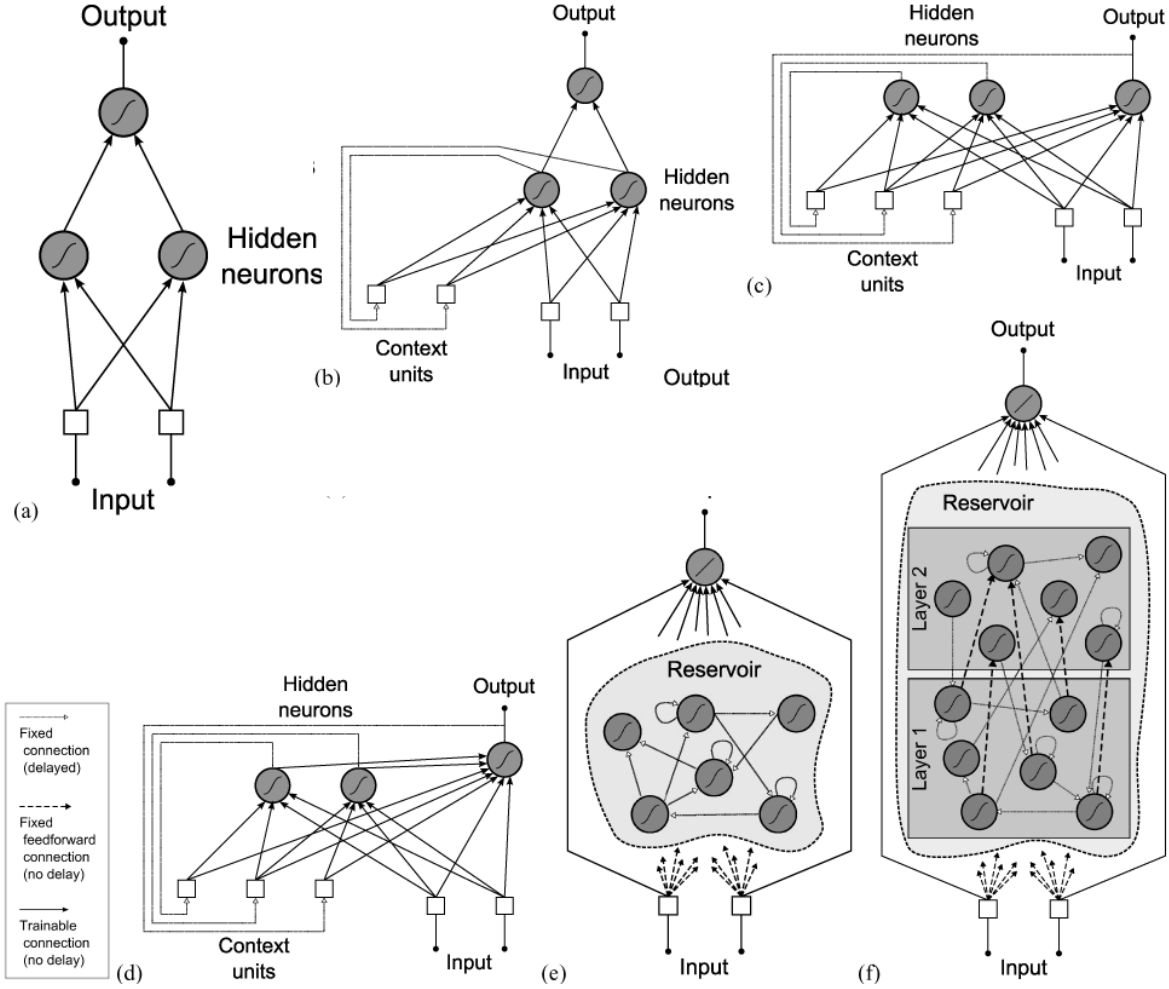
Fig. 1. (a) Feedforward ANN. (b) Elman recurrent ANN. (c) Williams–Zipser fully recurrent ANN. (d) Williams–Zipser fully recurrent and fully feedforward ANN. (e) Echo State Network. (f) Layered Echo State Network. Note: bias signals are omitted for